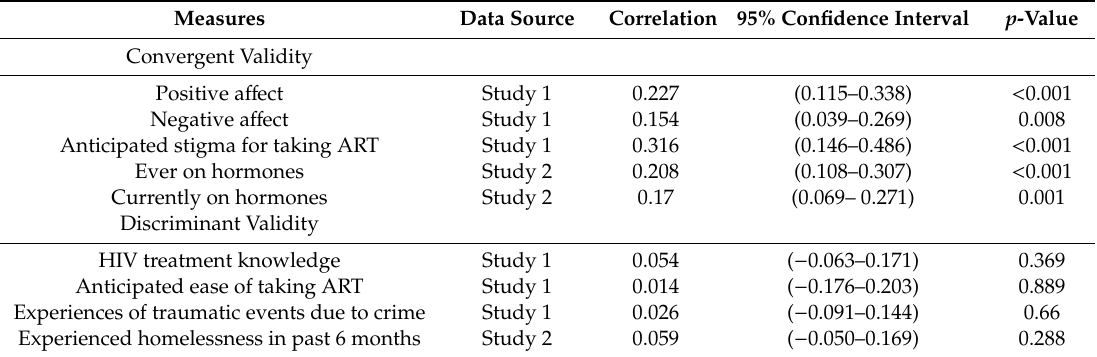
Table3. CorrelationsofTransgenderWomen’sImportanceofPronouns(TW-IP)withselectstudymeasures.